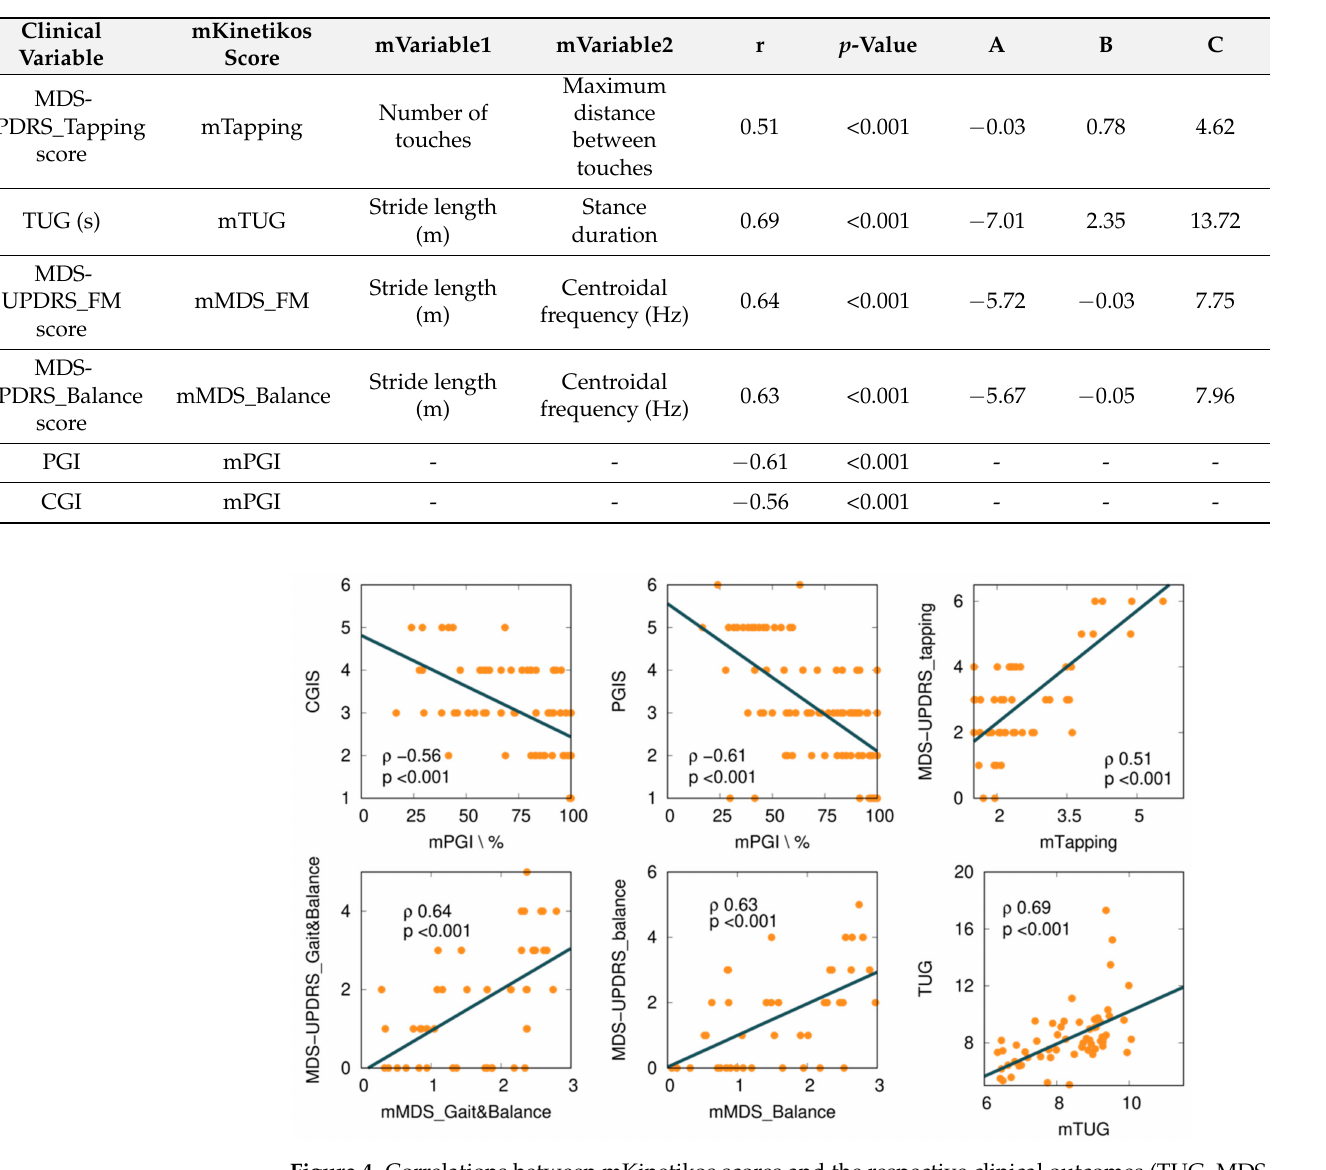
Figure 4. Correlations between mKinetikos scores and the respective clinical outcomes (TUG, MDS- UPDRS finger-tapping, gait and balance, and balance